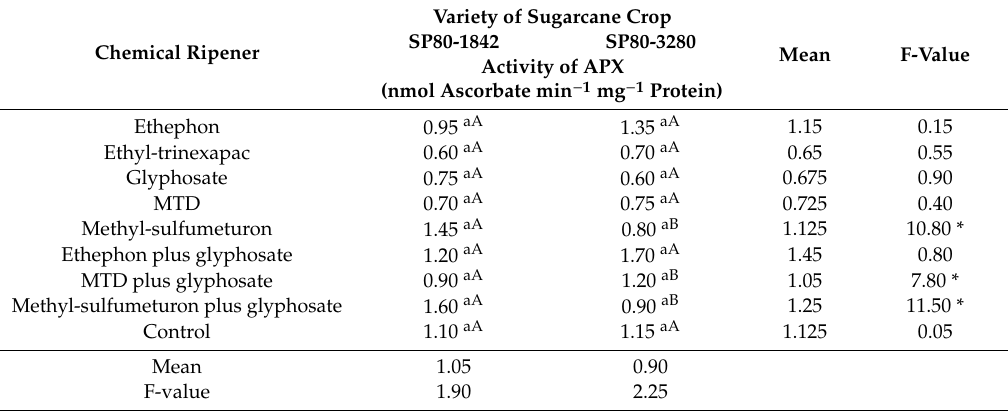
Table 4. Interaction e ff ect of chemical ripening agents and varieties of sugarcane on the activity of ascorbate